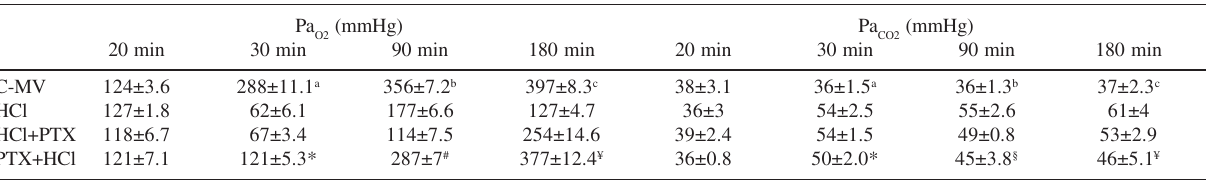
Table 1 - Pentoxifylline (PTX) and hydrochloric acid (HCl) effects on the arterial blood levels of Pa 90 and 180 minute time points. Data are shown as mean±SD.